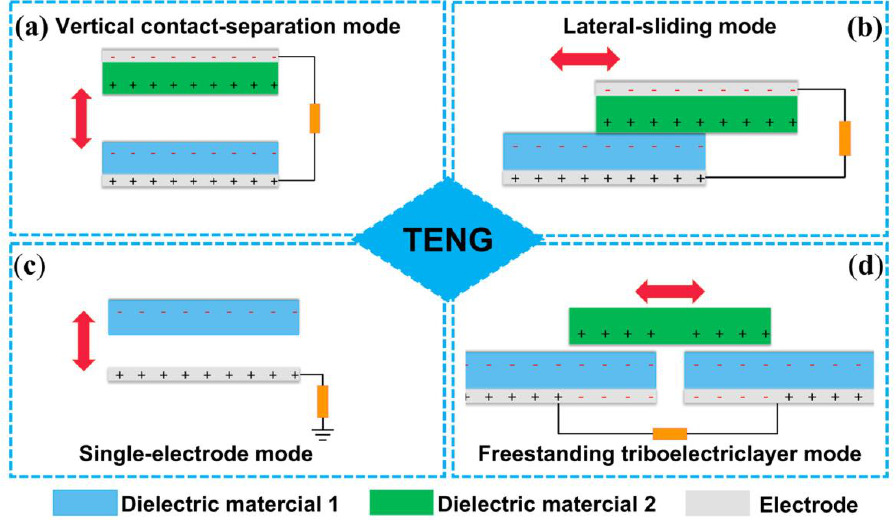
Figure 2. The four fundamental working modes of TENG: ( a ) vertical contact-separation mode [34]; ( b ) lateral-sliding mode [34]; ( c ) single-electrode mode [34]; and ( d ) freestanding triboelectric layer mode [34]; Copyright 2022, Multidisciplinary Digital Publishing